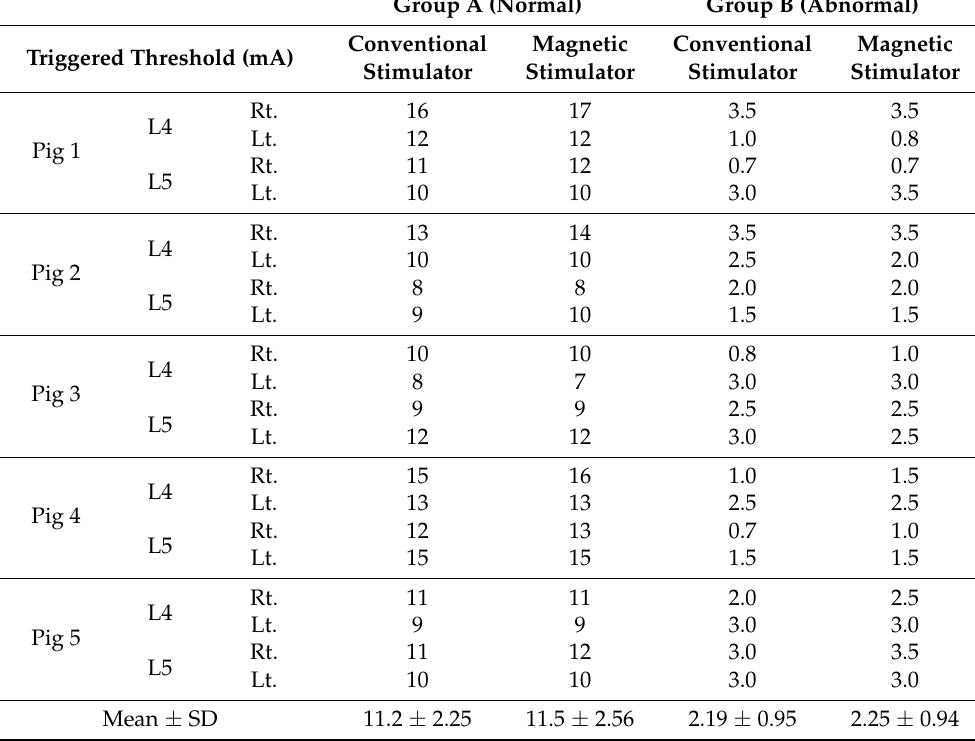
Table 1. Raw data of triggered threshold according to the use of conventional stimulator and novel magnetic